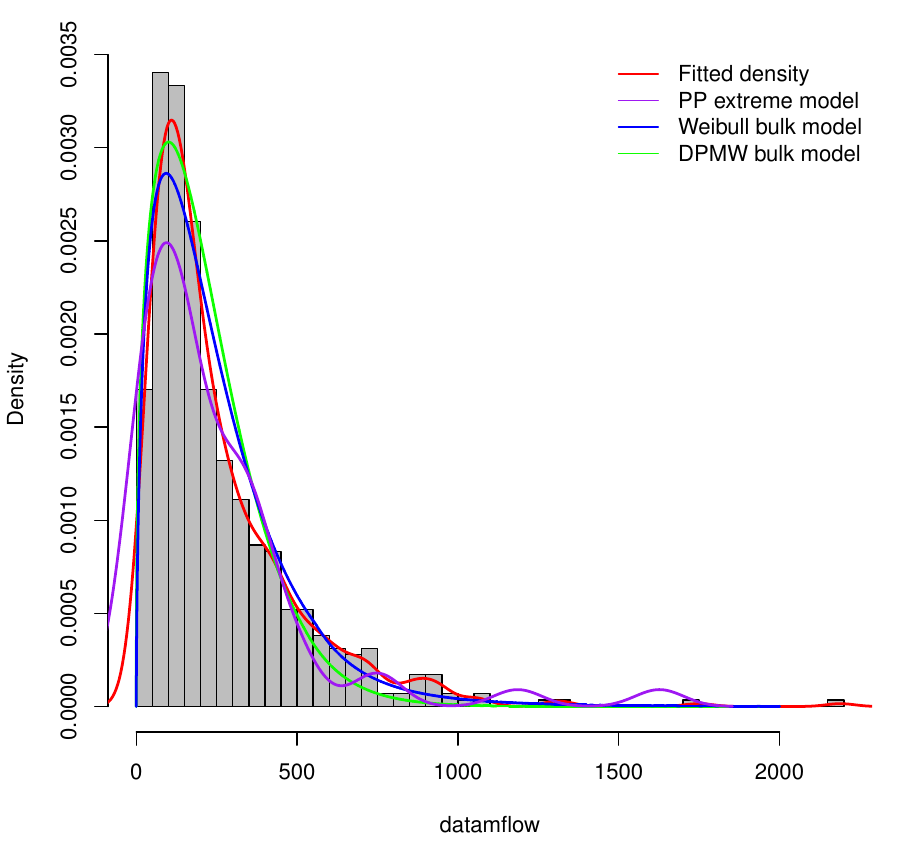
Figure 15. The posterior density plot for three models (the DPMW-PPR model, the PP extreme value model and the WMPP extreme model) fitted to the Iowa River monthly flow data. The red line shows the true density function, the green line, the blue line and the purple line are the posterior density function of the DPMW-PPR model, the WMPP extreme model and the PP extreme value model,